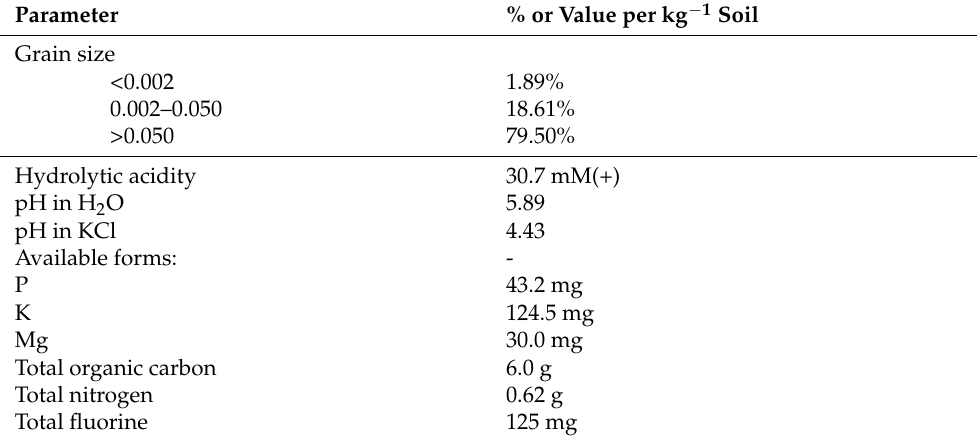
Table 1. Physico-chemical properties of soil.